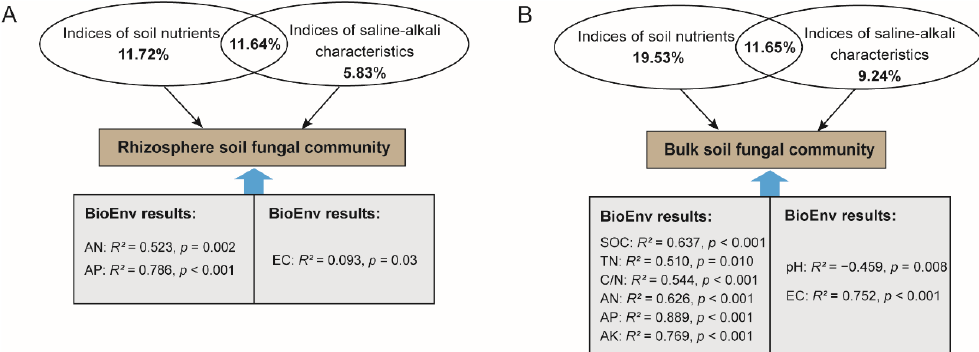
Figure 3. Variation partitioning analysis of the rhizosphere fungal ( A ) and bulk soil fungal ( B ) com- munities according to the BioEnv results. Indices of soil nutrients included SOC, TN, C/N, AN, AP,